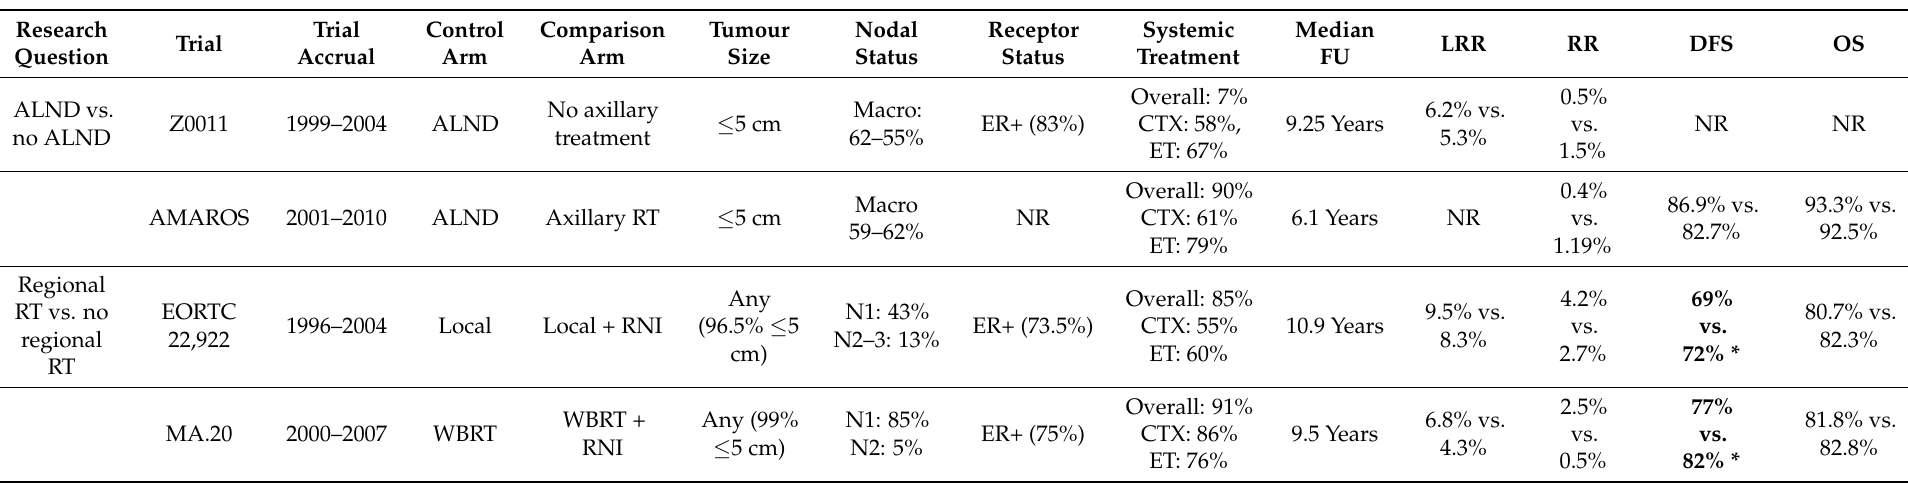
Table 2. Key trials in the intermediate-risk breast cancer